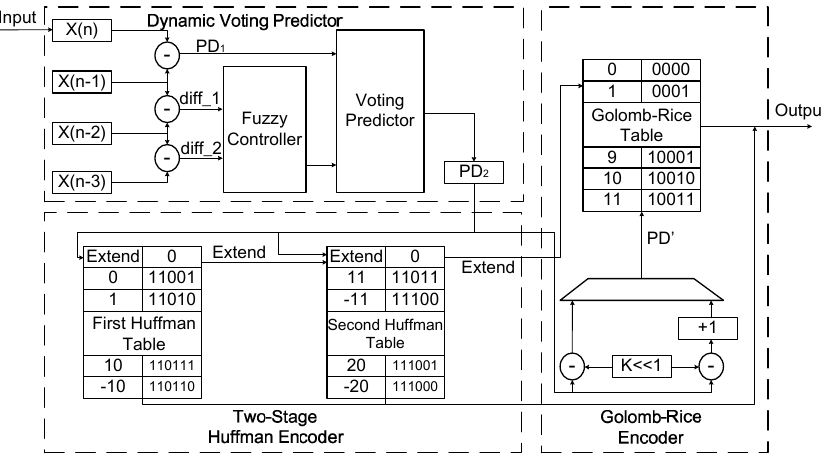
Figure 5. VLSI architecture of the proposed lossless EEG compression algorithm.